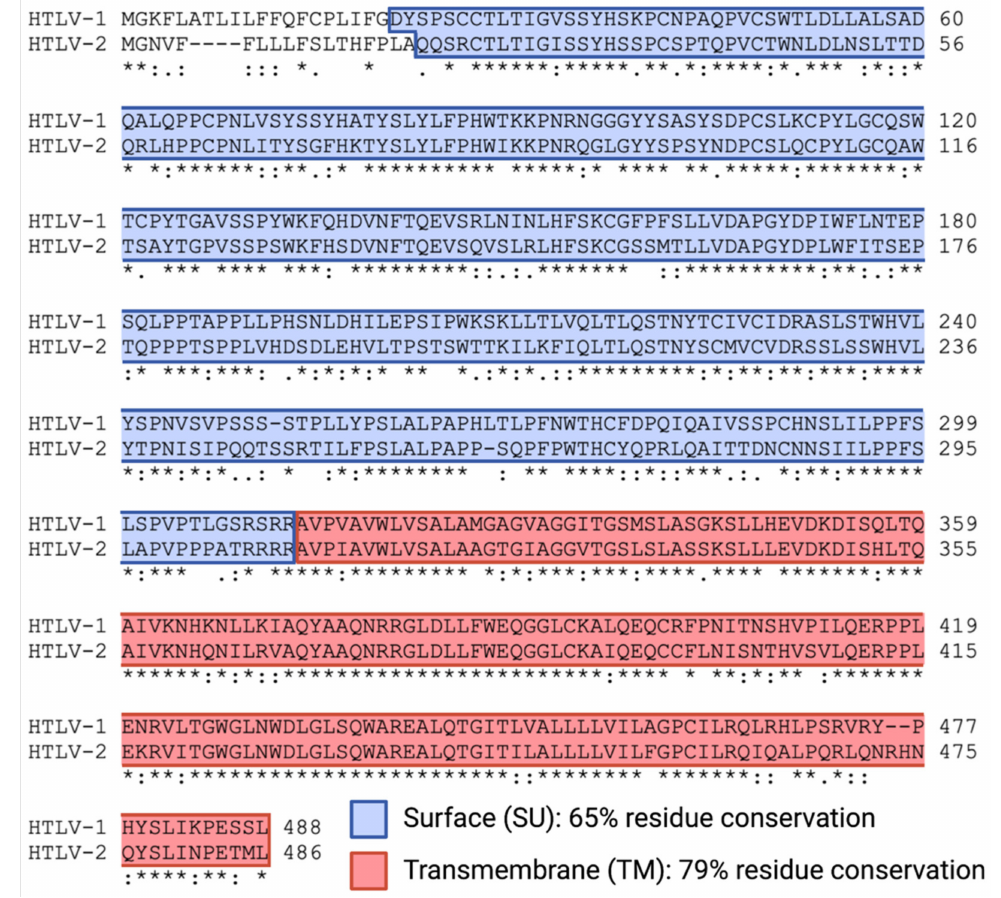
Figure 1. Amino acid sequence alignment of the HTLV-1 and HTLV-2 envelope proteins. The alignment was performed with the Clustal Omega program using the following UniProtKB accession numbers: P03381 for HTLV-1 Env and P03383 for HTLV-2 Env. The regions highlighted in blue and red